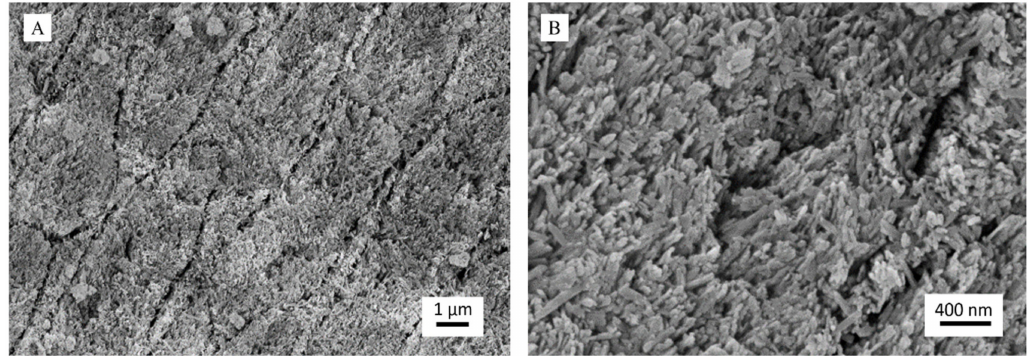
Figure 5. Representative FEG-SEM micrographs of demineralized dental enamel after treatment with